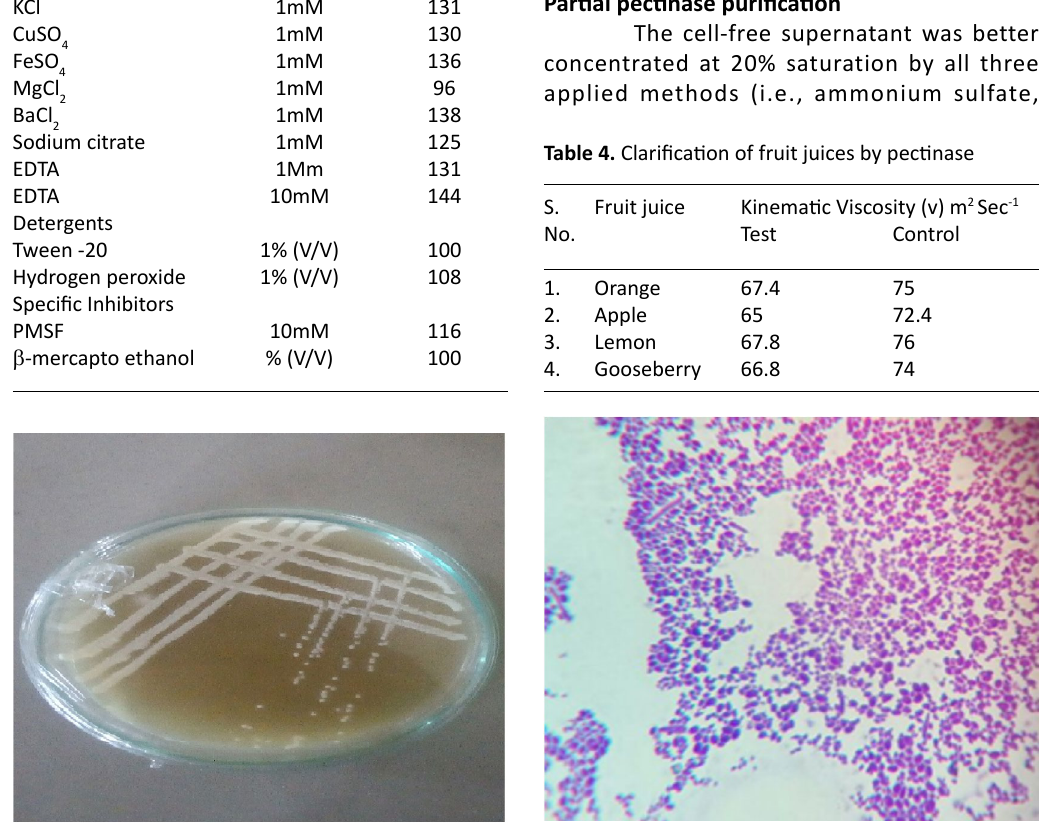
Fig. 1. Meyerozyma sp. VITPCT75 on YPPA Fig. 2 . Microscopic appearance of Meyerozyma